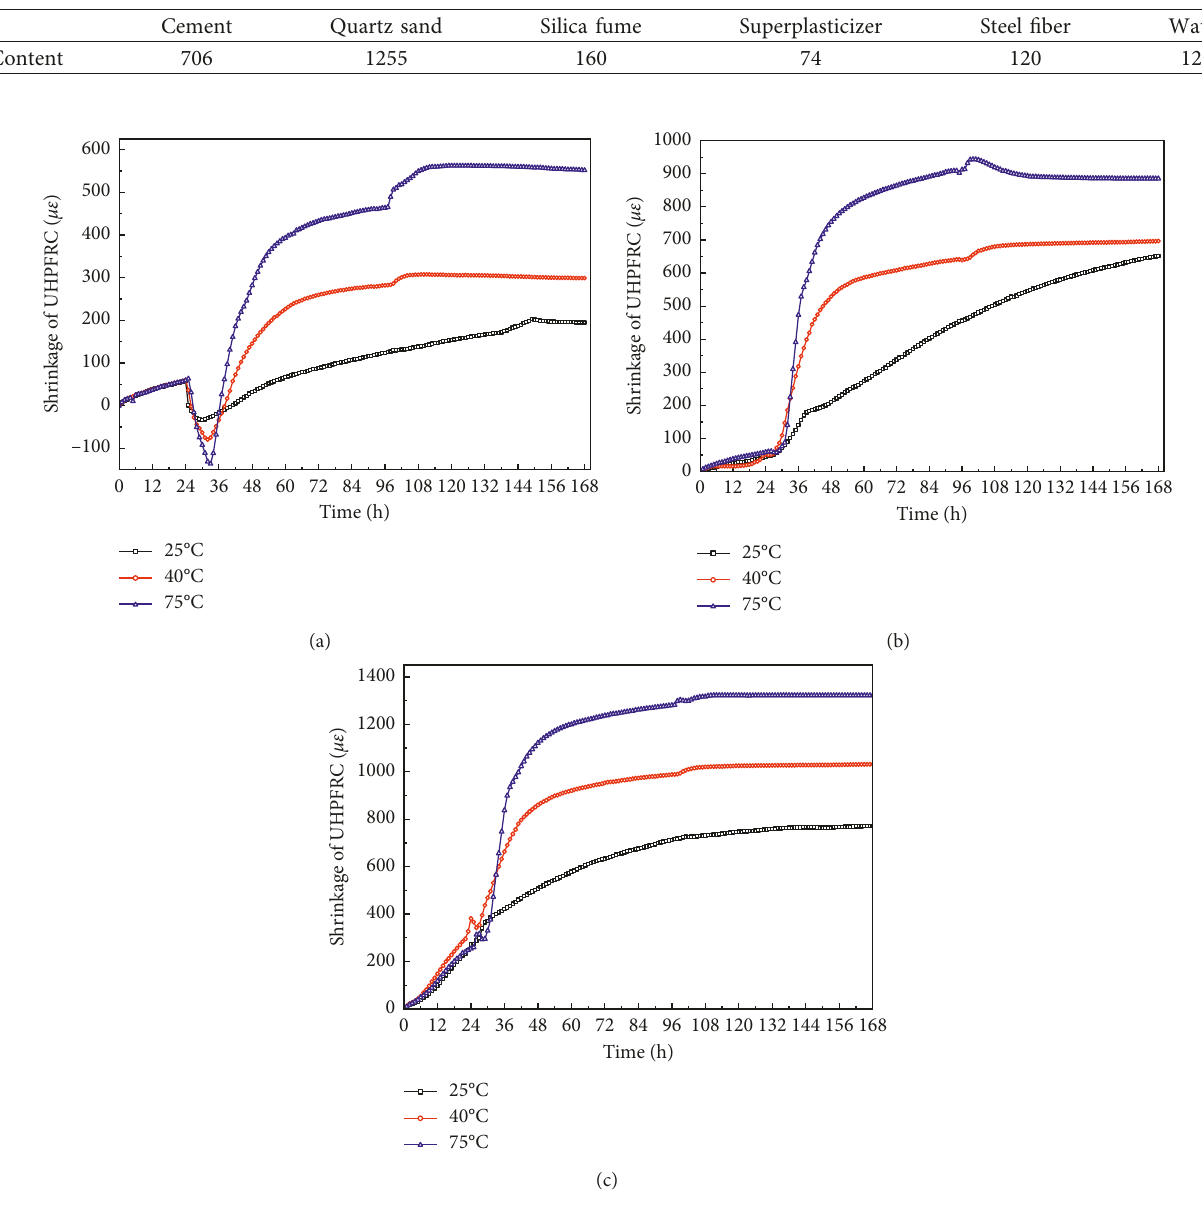
Figure 1: The shrinkage curve of UHPFRC in 168h. (a) Soaked condition. (b) Sealed condition. (c) Dry